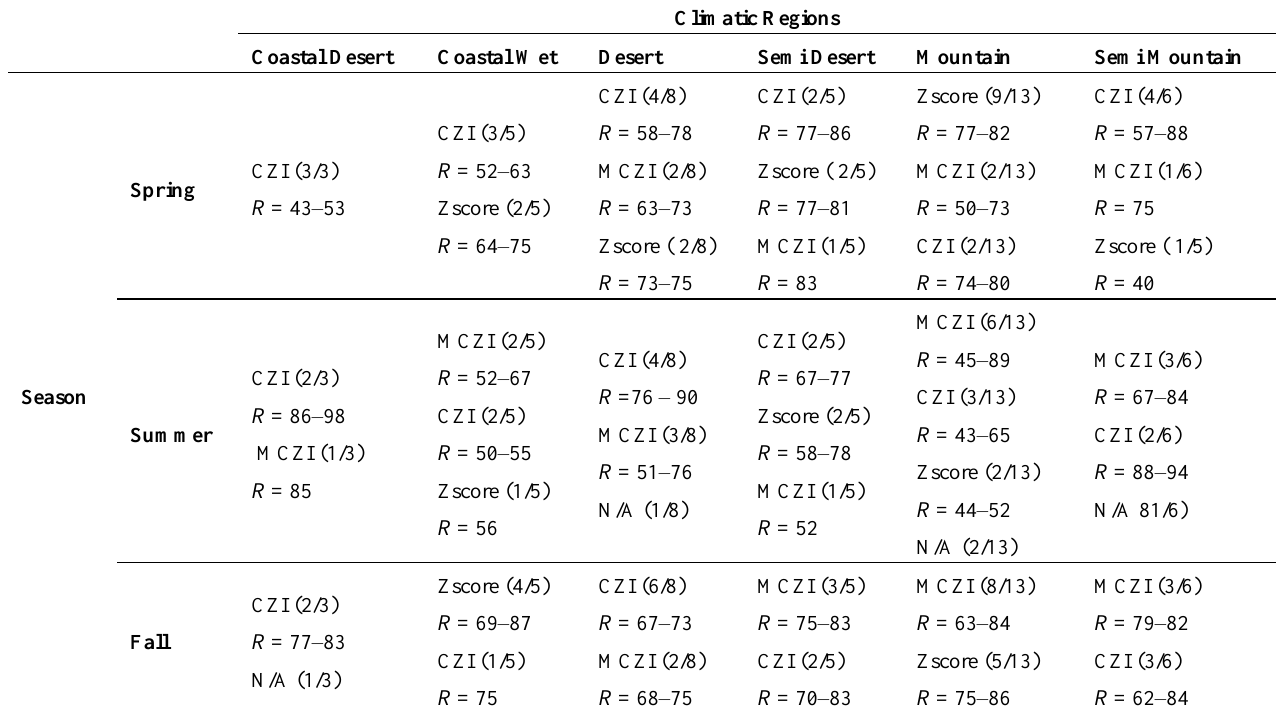
Table 4. The best indices according to region and time scale with the number of included stations per region in seasonal and annual analysis